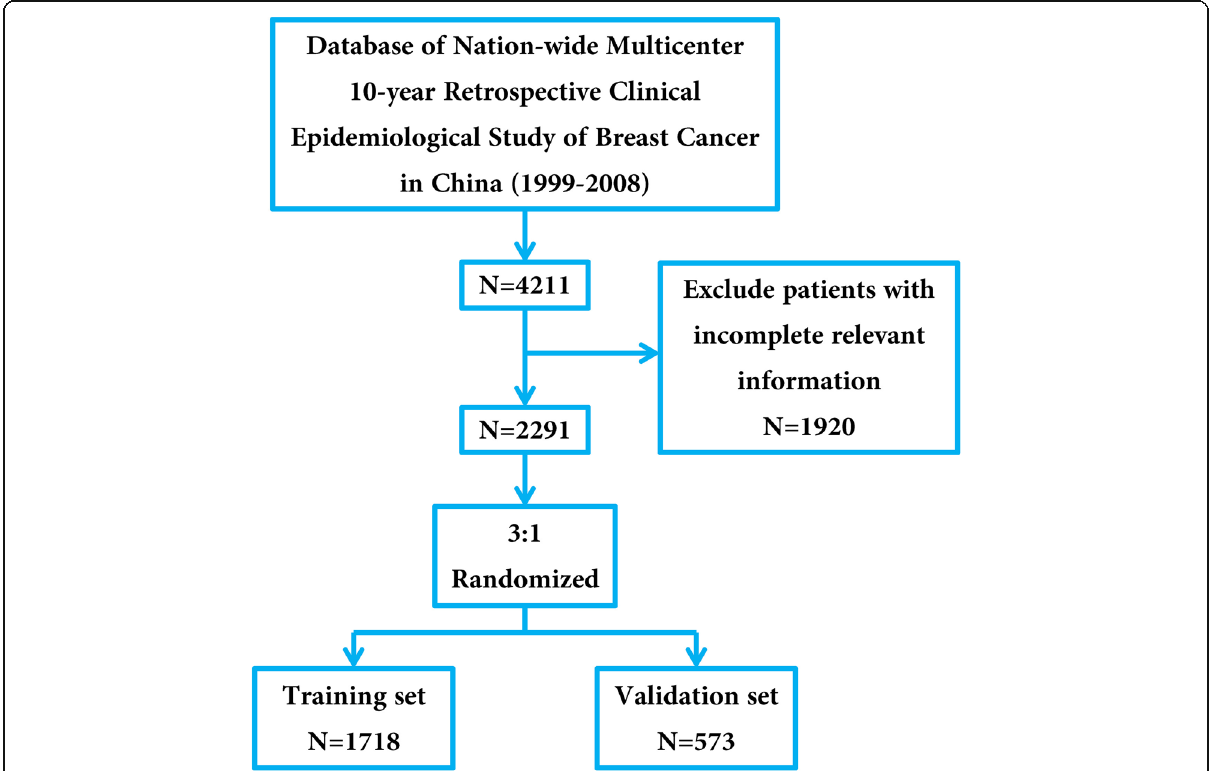
Fig. 1 Flow diagram of the study design. A total of 2291 patients with complete relevant information were enrolled in this study and were randomized 3:1 and divided into a training set ( N = 1718) and a validation set ( N =